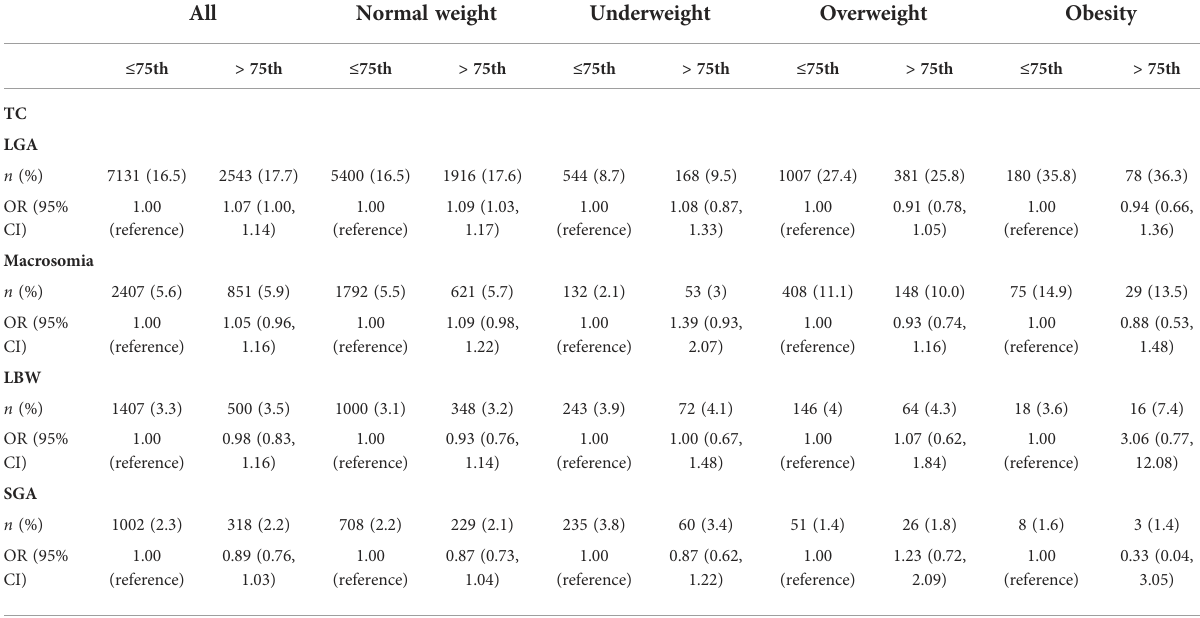
TABLE 4 Maternal lipid pro fi les and risks of LGA, macrosomia, LBW, and SGA by BMI groups. All Normal weight Underweight Overweight